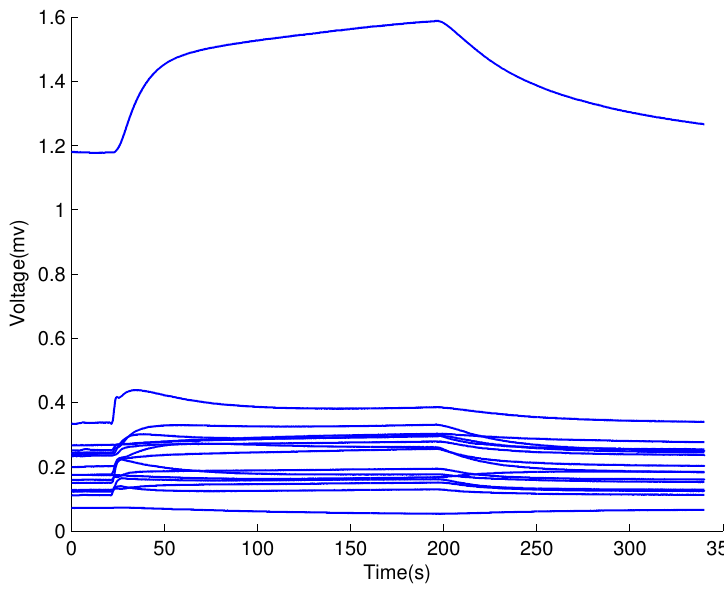
Figure 3. Typical response curves of 16 metal-oxide semi-conductive sensors to a